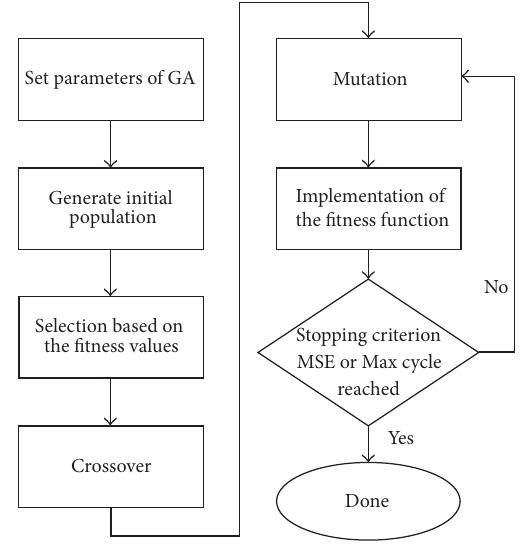
Figure 1: Basic process of the genetic algorithm as flowchart (adapted from